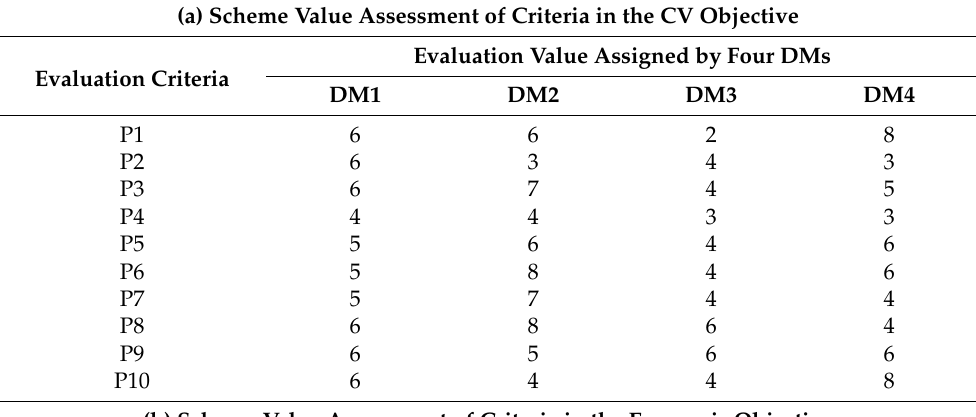
(b) Scheme Value Assessment of Criteria in the Economic Objective Evaluation Criteria